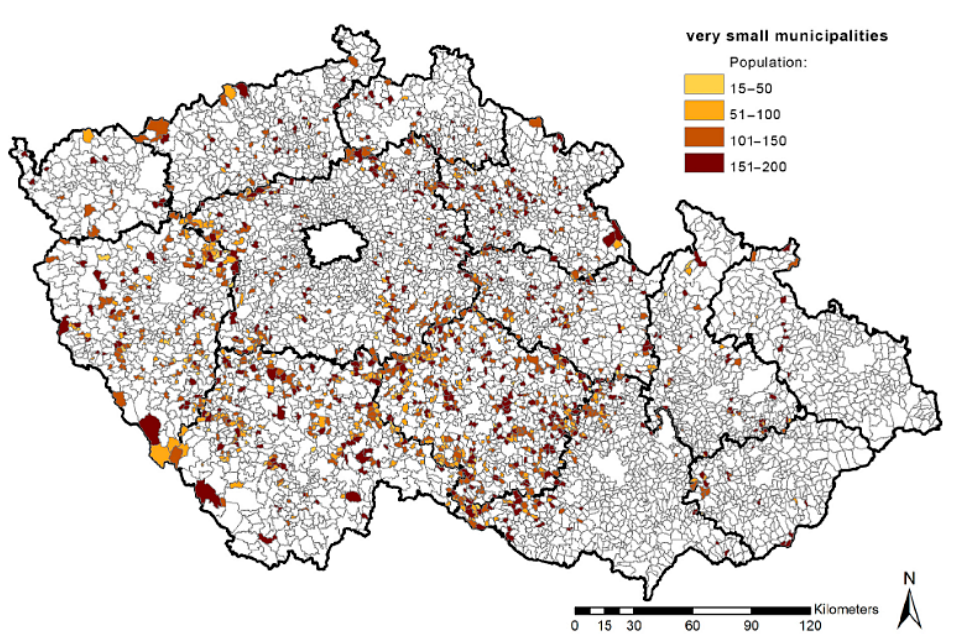
Figure 8. Localization of very small municipalities in the Czech Republic. Source: [42].